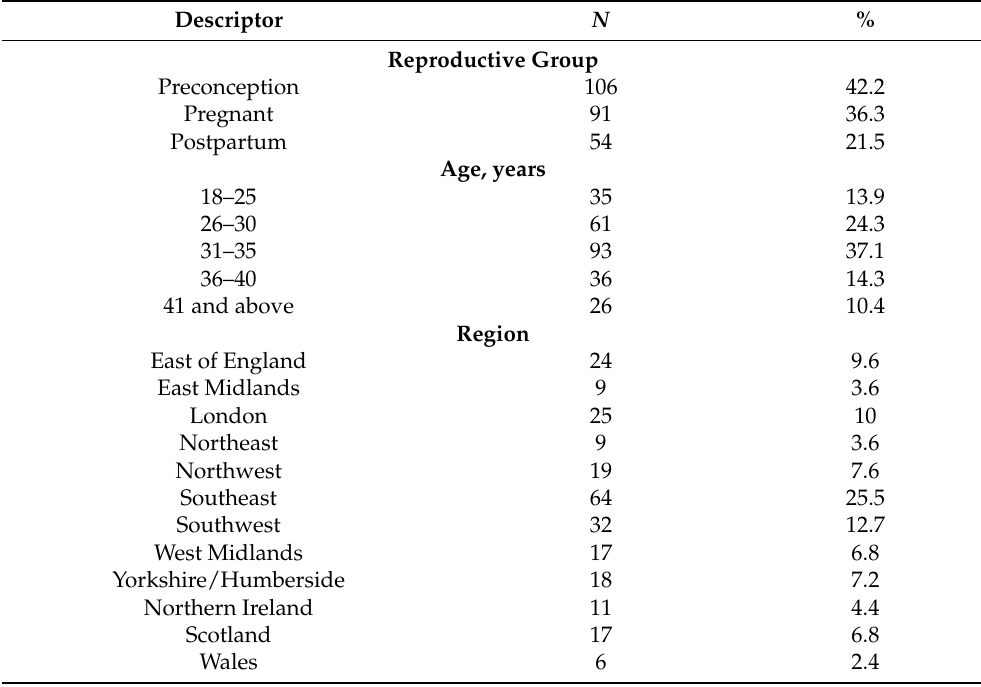
Table 1. Demographic characteristics of survey participants